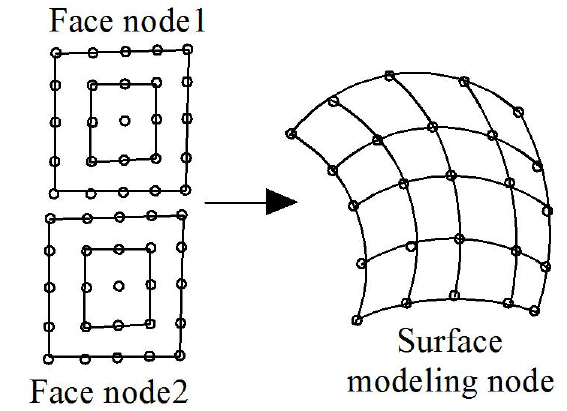
Fig. 3. Preliminary design of algorithm schematic